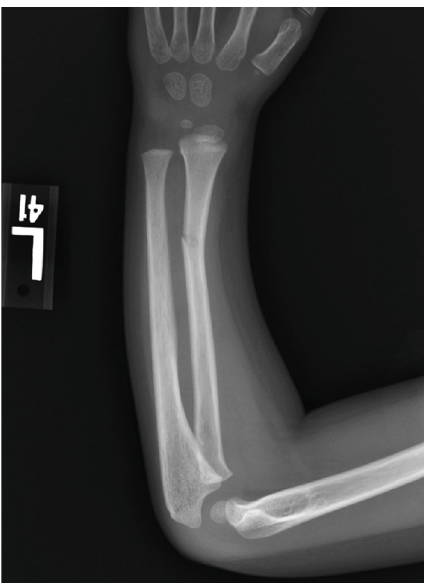
Figure 3: A radiograph demonstrating the left distal radius revealing a minimally angulated greenstick fracture.